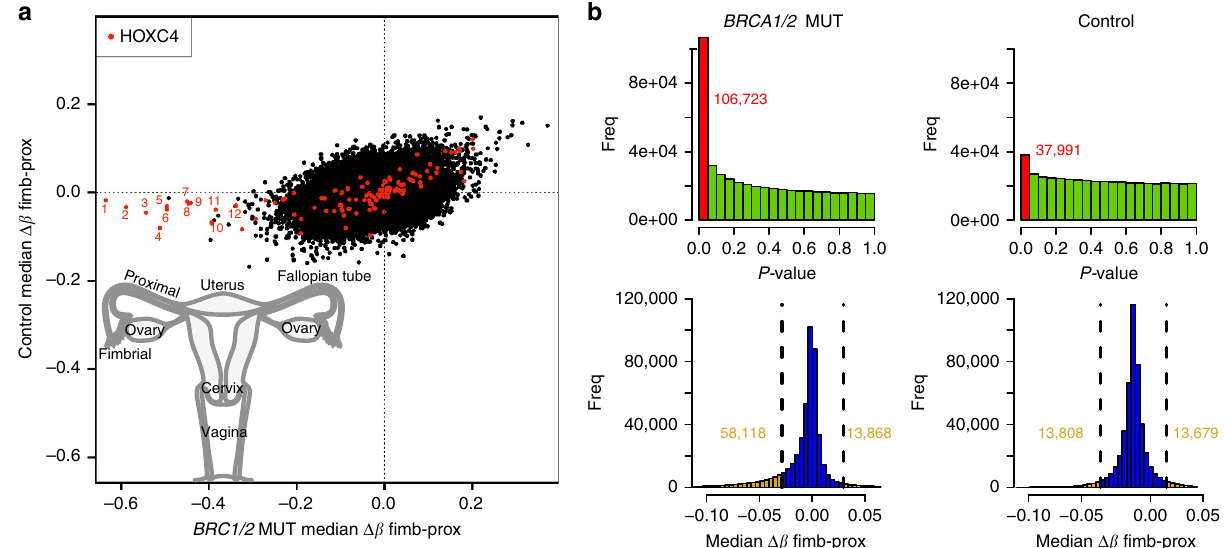
Figure 1 | Differences in methylation profiles of the proximal versus fimbrial fallopian tube compartments in BRCA mutation carriers and controls. ( a ) Scatter-plot showing methylation differences ( D b ) between the fimbrial and proximal (fimb-prox) compartments of fallopian tubes in control volunteers ( n ¼ 49) and BRCA1 / 2 mutation carriers ( n ¼ 52). The 12 CpGs located at the HOXC4 locus and showing the largest methylation difference in BRCA1 / 2 mutation carriers are indicated in red and numbered. ( b ) (top) T -test p -value histograms showing concentrations of significant CpGs discriminating fimbrial from proximal compartments (one p -value per CpG); (bottom) histograms of median D b fimb-prox (across all samples, one median per CpG) showing the magnitude of b differences between fimbrial and proximal